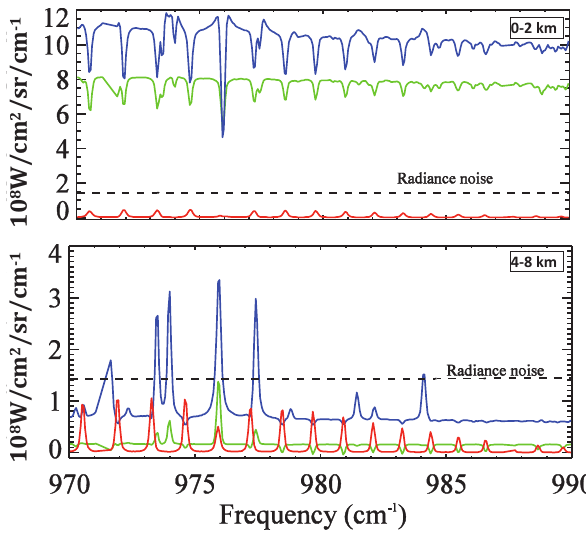
Fig. 1. Radiance change resulting from perturbations of +10% to water (blue), − 1K to atmospheric temperature (green) and 10ppm to CO 2 (red). The perturbations are applied to the boundary layer (0–2km) (top) and to the free troposphere (4–8km) (bottom). The applied perturbations to water and temperature are of the same order as the predicted errors.